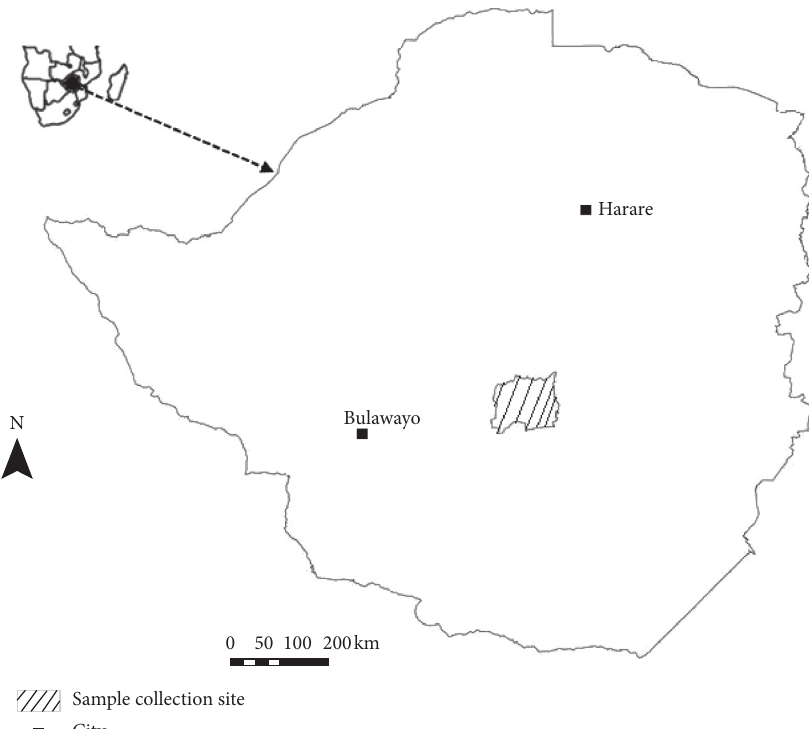
Figure 1: Map showing Marula nuts collection area of Shurugwi district,